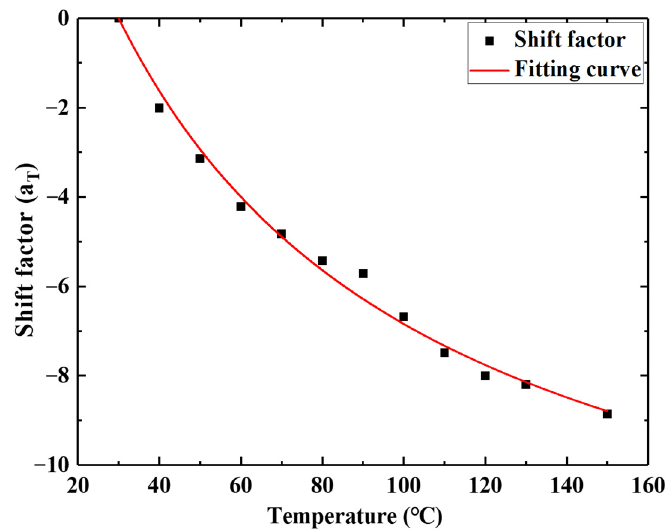
Figure 11. Migration coefficient fitting curve. Table 3. Parameters of the WLF equation.